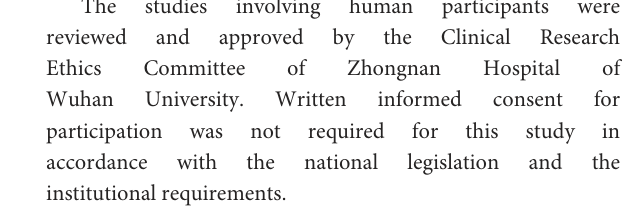
figure preparation. All authors drafted text and proofed the final version of the